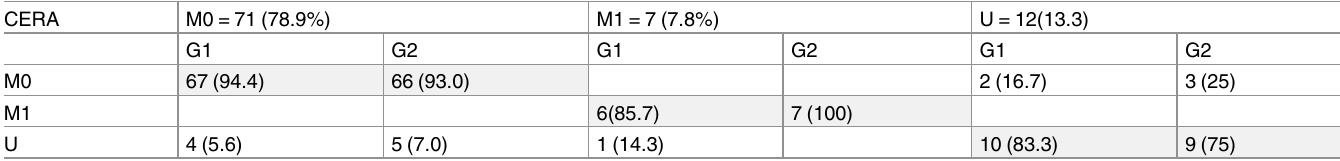
Table 6. Comparison of maculopathy graded by the CERA grader and local graders after learning from a test set of 32 eyes graded by the CERA grader. CERA M0 = 71